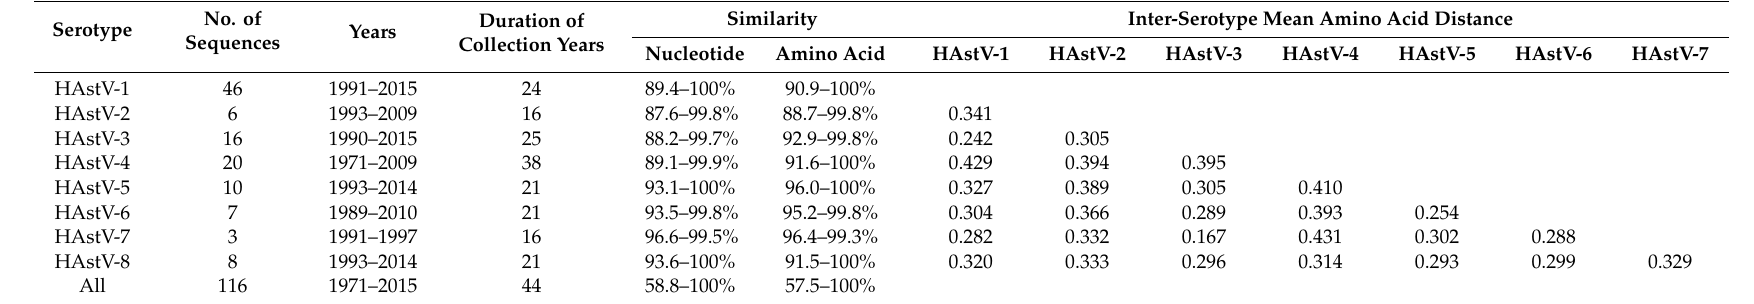
Table 1. Summary of the complete capsid sequences of classic human astroviruses (HAstVs) analyzed in this study.